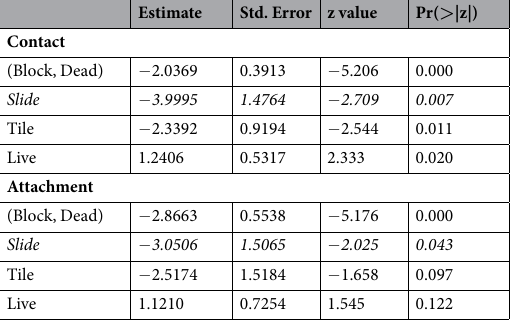
Estimate Std. Error z value Pr( > |z|)